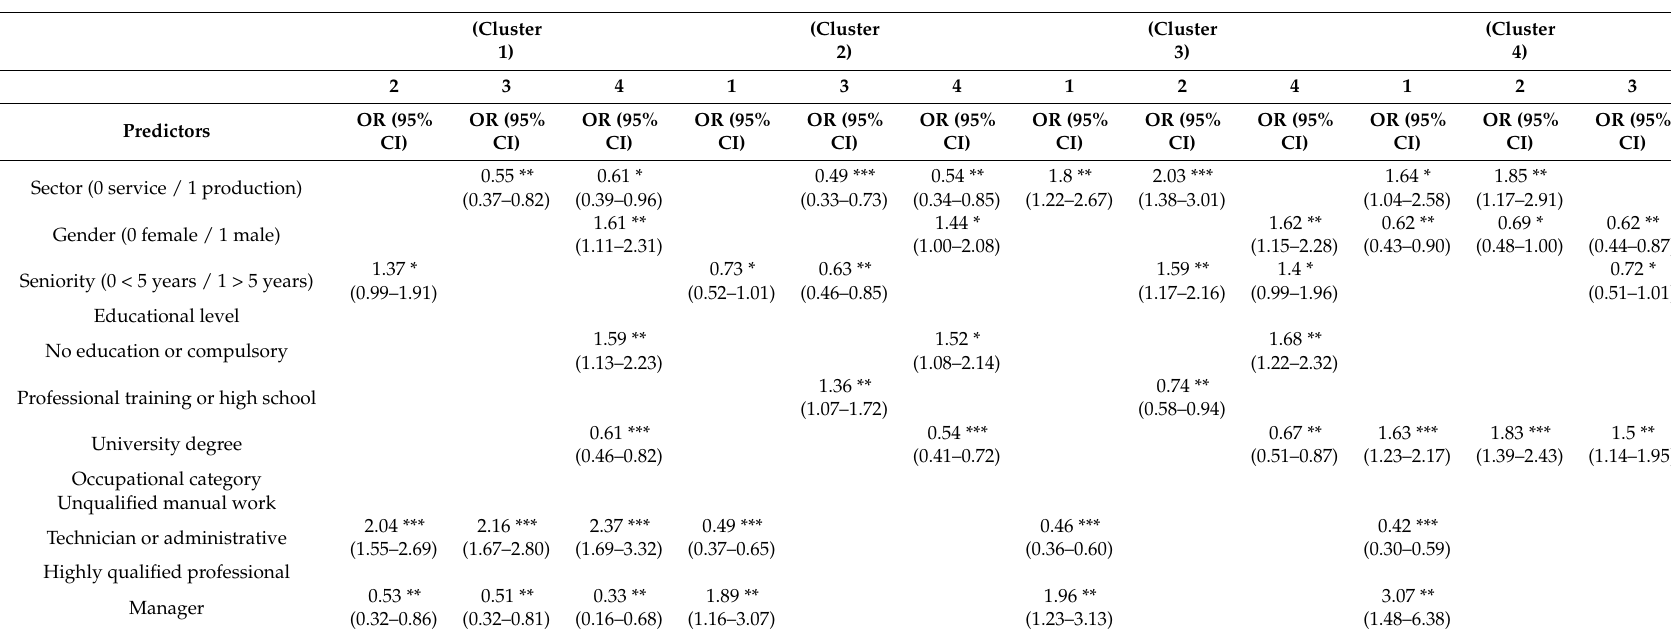
Table 3. Multinomial logistic regression analysis of factors associated with the clusters. Model 1: Hedonic (H) Performance employee